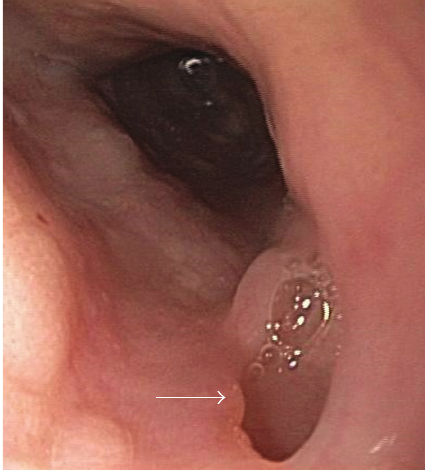
Figure 2: Esophagoduodenoscopic image demonstrating a chronic- appearing, well-epithelialized fistulous tract (arrow) at approxi- mately 24 cm (8cm distal to upper esophageal sphincter). Image courtesy of Dr. Gene Bakis.